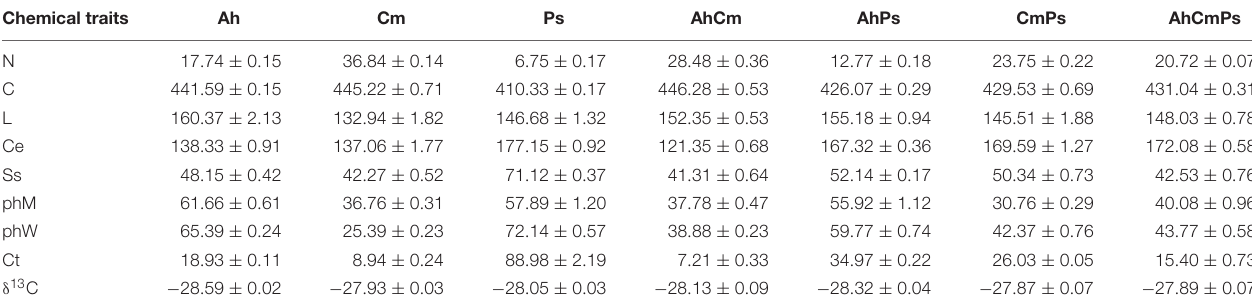
TABLE 1 | Initial litter chemical traits and δ 13 C of three single species and their mixtures. Chemical traits